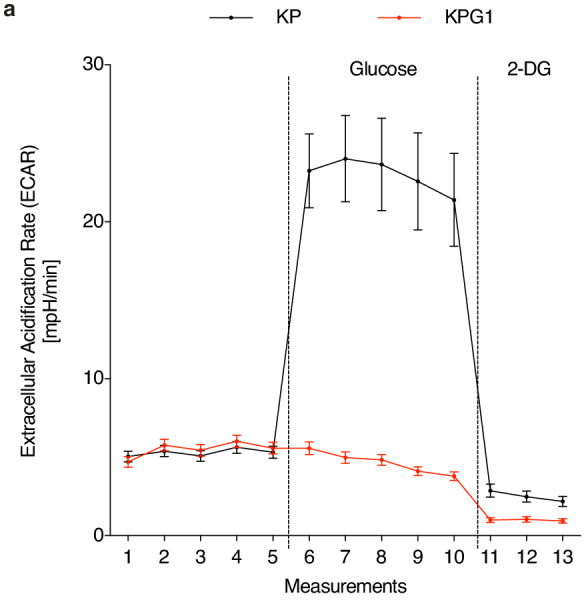
Glut1 deletion compromises ex vivo glycolytic metabolism.(a) Freshly-isolated tumor-derived cells were placed in a Seahorse XF analyzer and subjected to longitudinal extracellular acidification rate (ECAR) measurements. Glucose or 2-deoxyglucose (2-DG) were added where indicated. Data are means ± s.e.m. of 3 KP and 3 KPG1 tumor-derived cells each analysed in ten technical replicates.Figure 3—figure supplement 1—source data 1.Source files for Seahorse analysis of KP and KPG1 tumors.